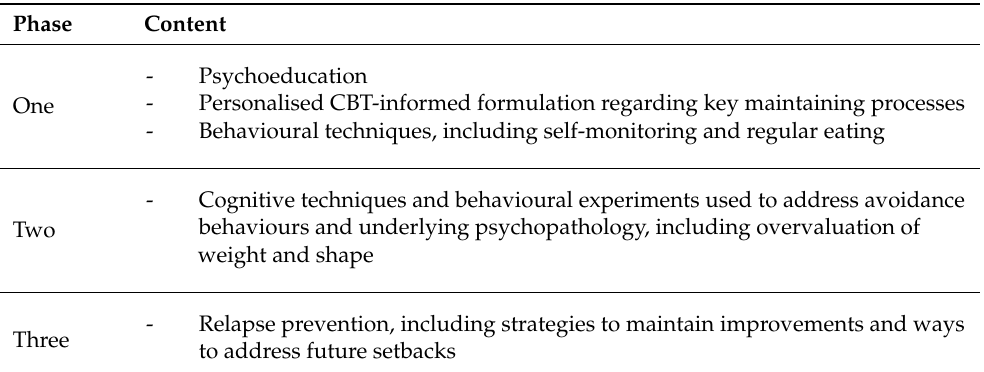
Table 2. Therapeutic strategies employed within Cognitive Behavioural Therapy for